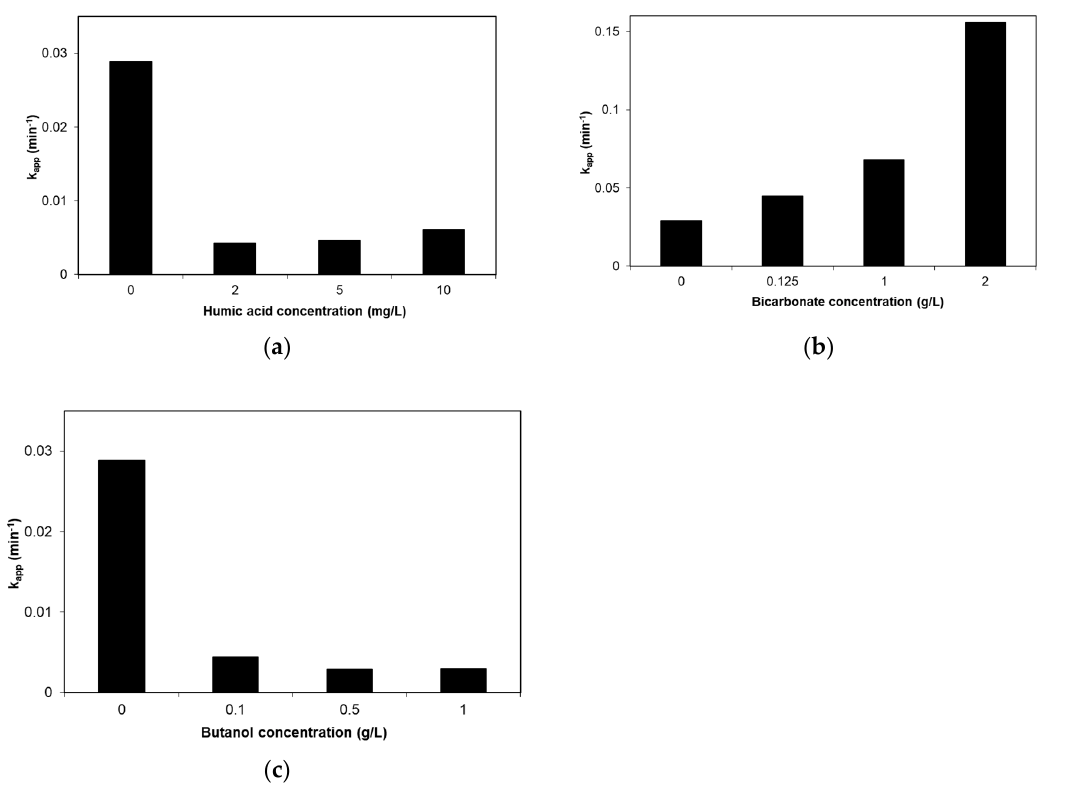
Figure 10. Effect of humic acid ( a ), bicarbonate ( b ), tert-butanol ( c ) on the photocatalytic degradation of SMX in UPW. [SMX] = 234 μ g/L, [0.04%Fe/TiO 2 ] = 1 g/L and natural pH.